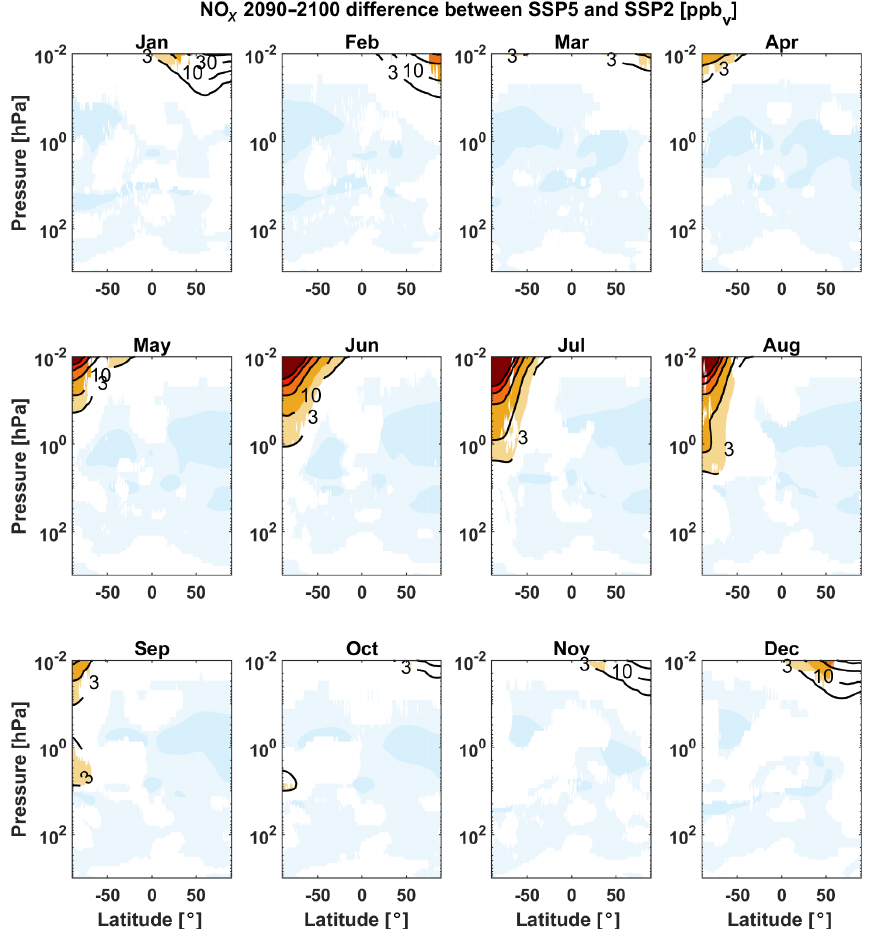
Figure 8. Monthly zonal mean NO x difference between SSP5 and SSP2 in ppb during 2090–2100. Positive contour levels are 3, 10, 30, 60 and 90ppb (solid lines). Colours represent areas significant at the 95% level calculated with a Monte Carlo simulation and a false detection rate. All negative responses are below −